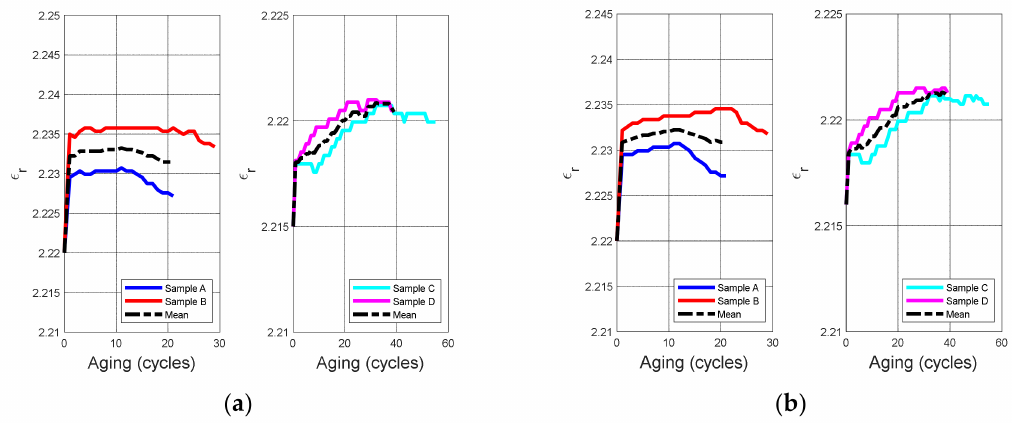
Figure 11. Relative permittivity ( ε r ) at 50 Hz and ( a ) 2 kV and ( b ) 12 kV.